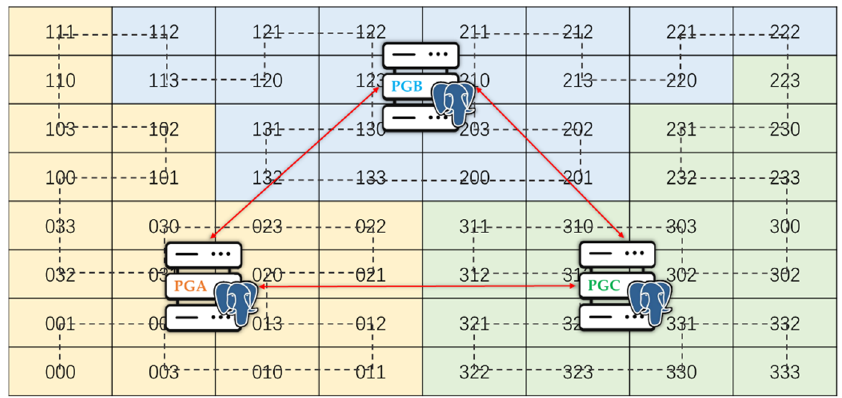
Figure 22. Databases distribution based on Hilbert grids.